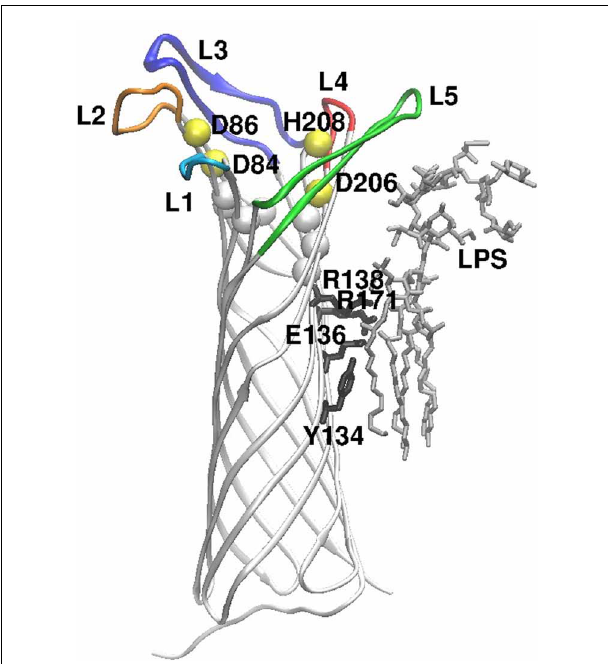
FIGURE 1 | Overall structure of the Pla protein, oriented perpendicular to the membrane plane, exracellular side up. The peptide chain is shown as white strands, and the extracellular loops are colored (L1–L5). The yellow spheres show positions of the active site residues (named) and the white spheres locate conserved residues at the bottom of the active site. On the right side of the image, LPS and the amino acids that contact it are shown in stick models (gray and black, respectively). The figure is modified from the crystal structure of Pla (Eren et al., 2010; Eren and van den Berg,